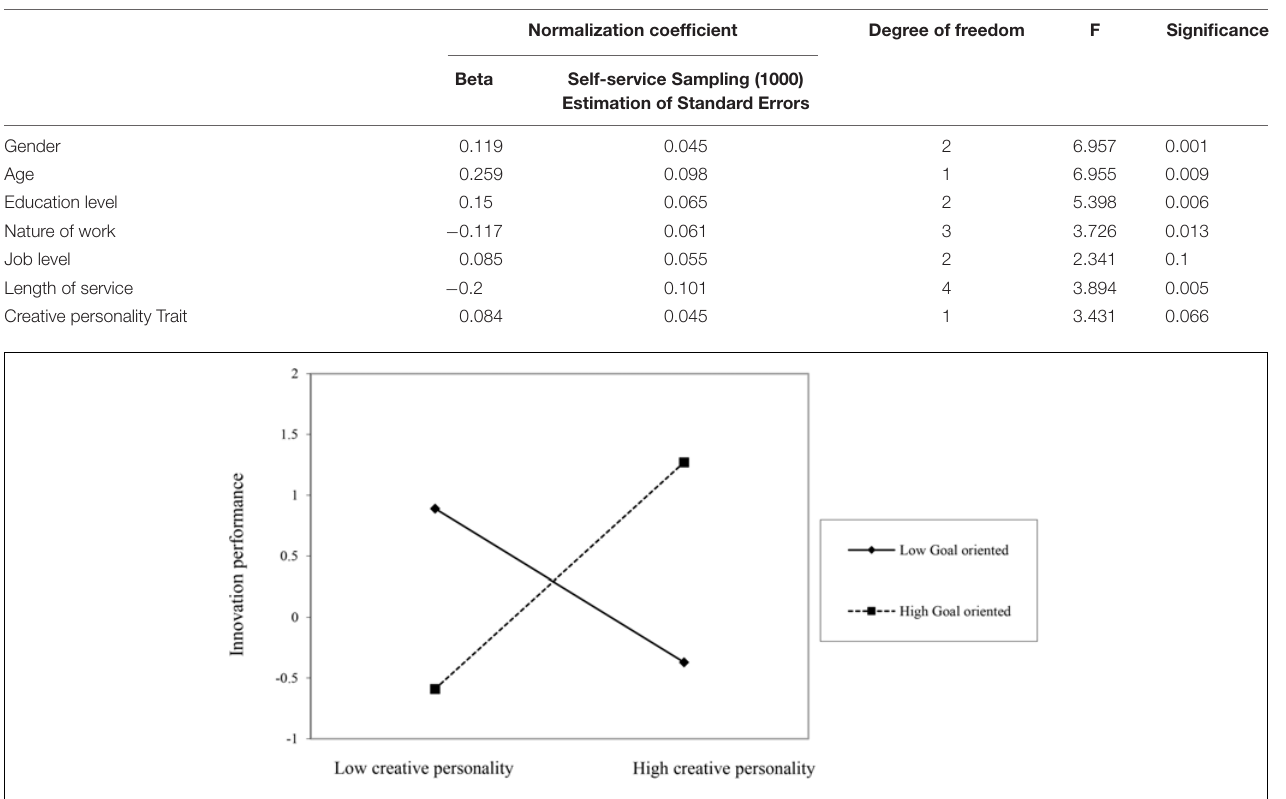
FIGURE 1 | Goal orientation moderates the relationship between creative personality traits and employee innovation performance.